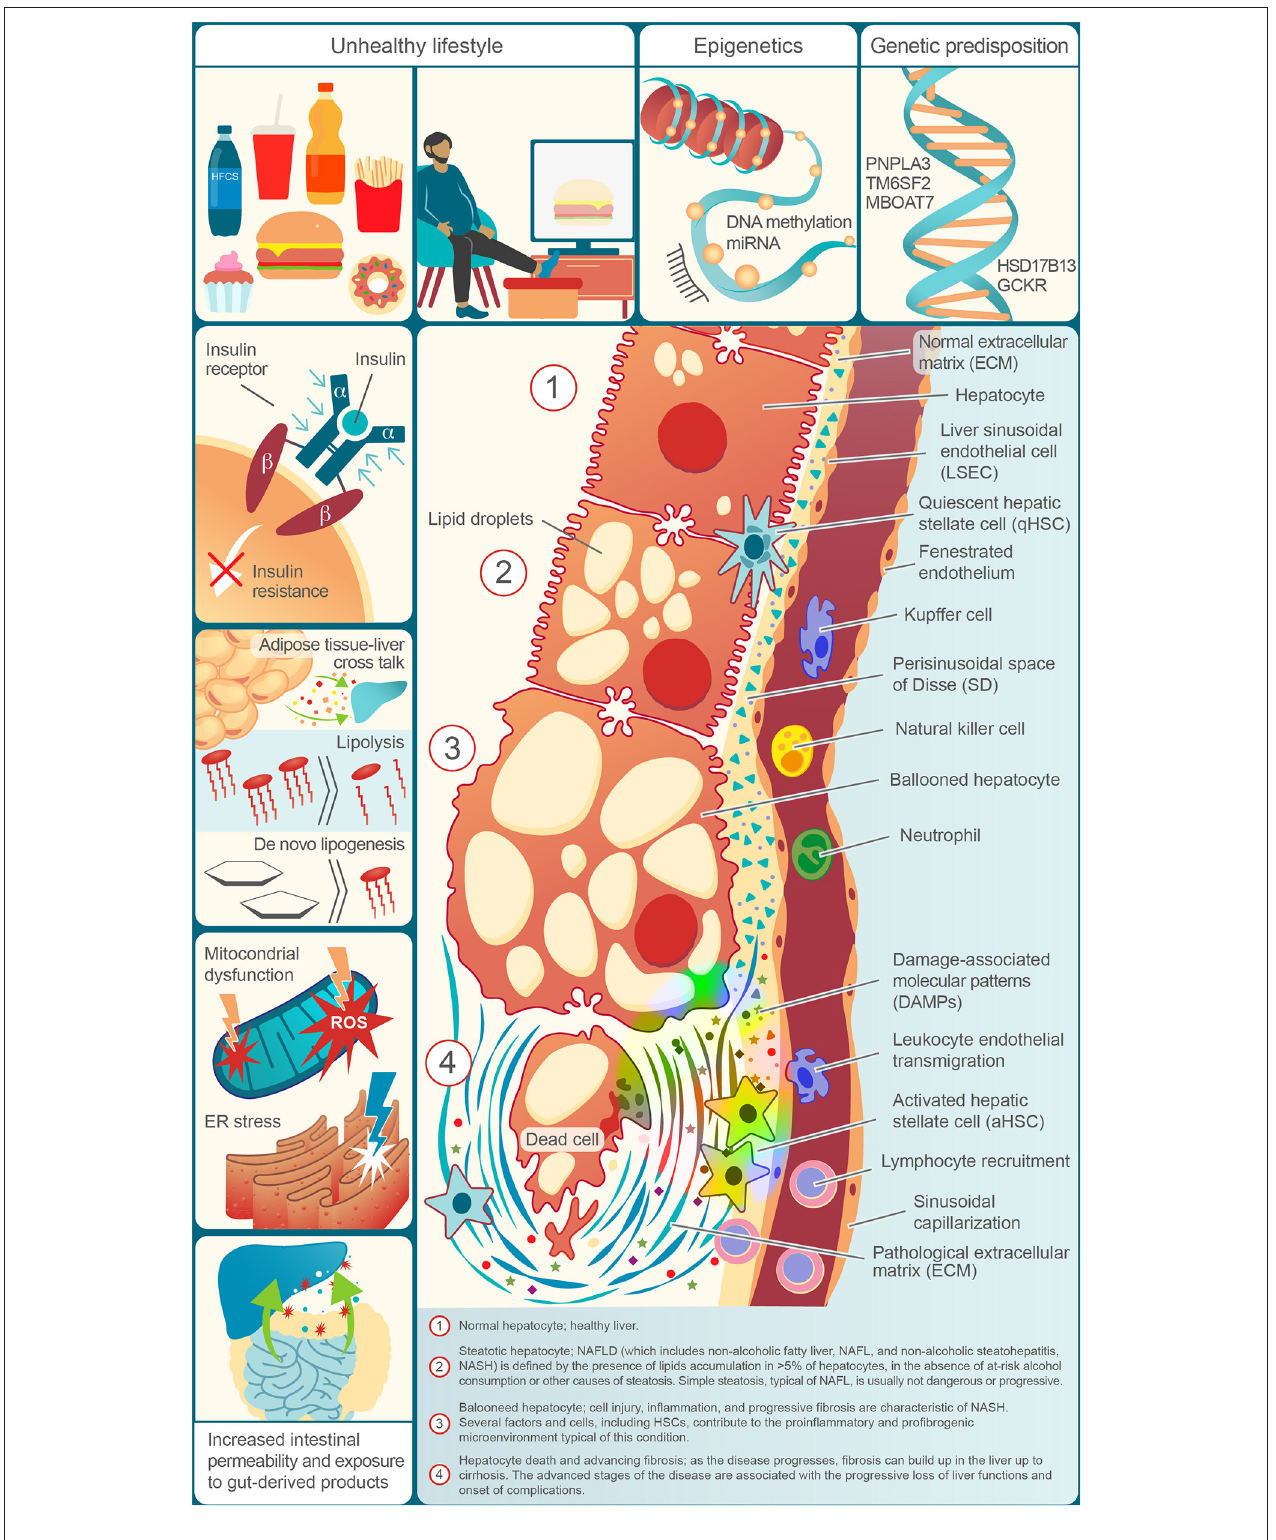
FIGURE 1 | Risk factors, physiopathological molecular events, and typical elements of the NAFLD spectrum in a decorative, cell by cell, succession.